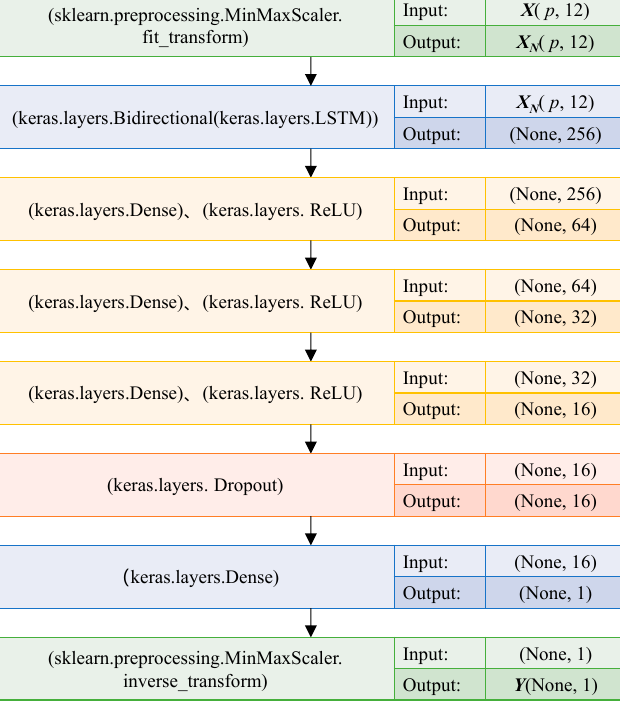
Figure 9. Bi-LSTM single indicator model network structure.